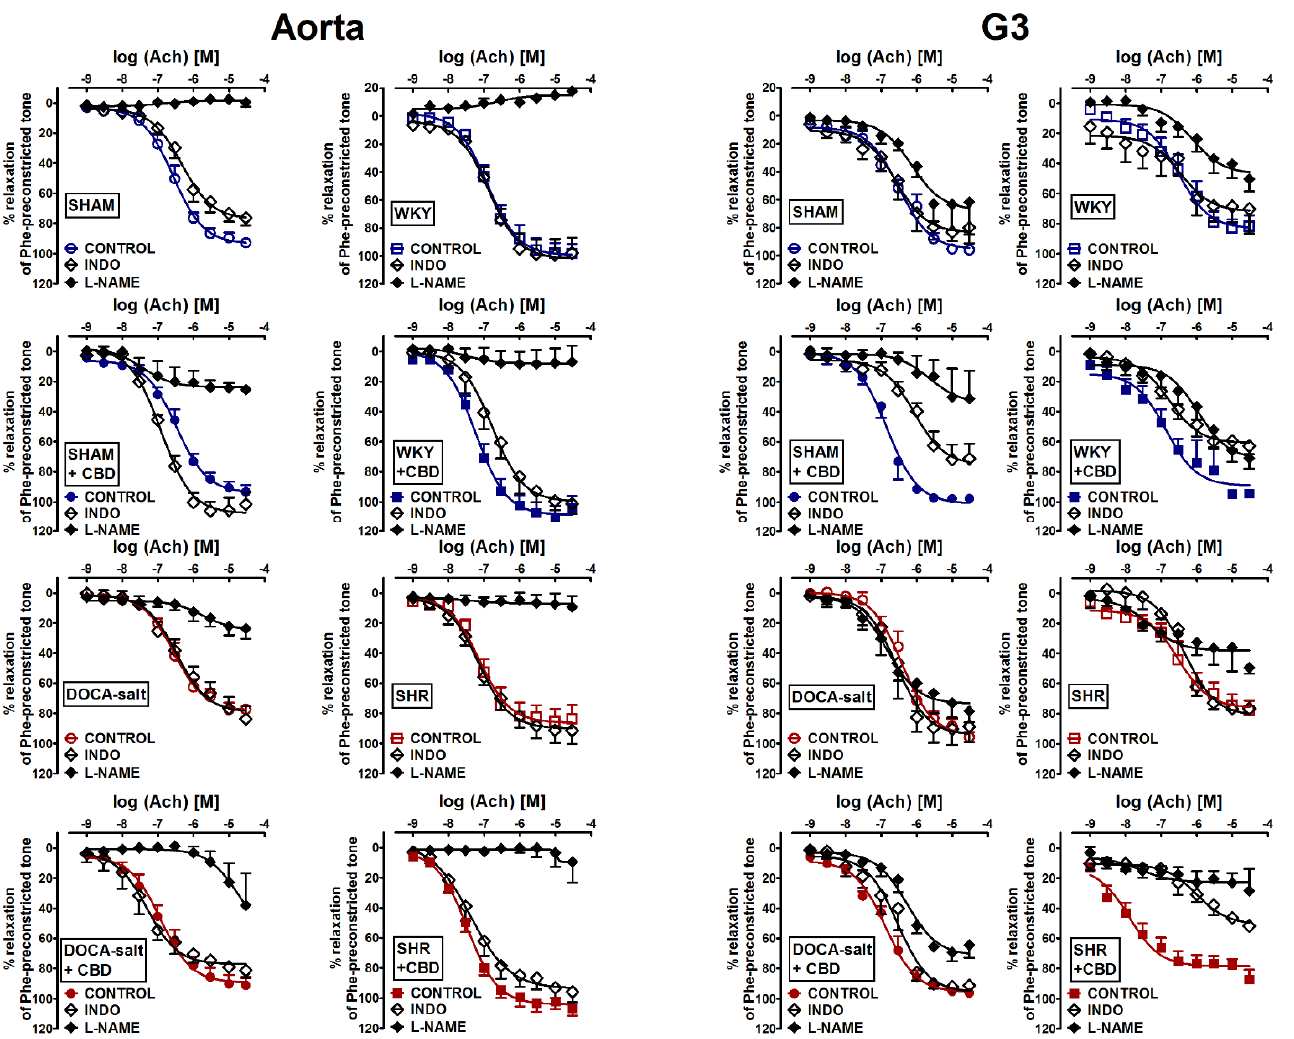
Figure 3. Influence of cannabidiol (CBD) and its vehicle on the vasorelaxant effects of acetylcholine (Ach) in the presence of inhibitors of nitric oxide synthase—N G -nitro-L-arginine methyl ester (L-NAME, 300 μ M) or cyclooxygenase 1 and 2-indomethacin (INDO, 10 μ M) in aortas and the mesenteric G3 arteries isolated from deoxycorticosterone-induced (DOCA-salt) and spontaneously (SHR) hypertensive rats and their normotensive controls, sham-operated (SHAM) and Wistar–Kyoto (WKY) rats, respectively. CBD (10 mg/kg) or its vehicle was injected i.p. every 24 h for 14 days. Vasodilatory responses are shown as percentages of the reference response of the isometric contraction induced by phenylephrine (Phe). Mean ± SEM of n = 4–8 tissues for each curve. In a few cases, the SEM is smaller than or equal to the size of the symbols. See Tables 1 and 2 for statistical analysis.